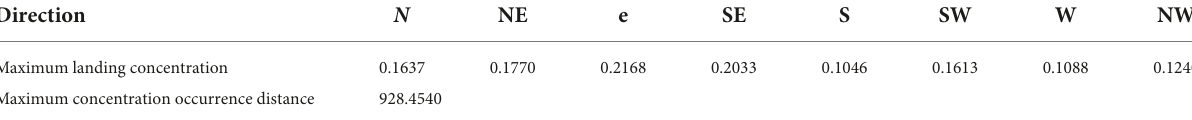
TABLE 11 Distances at which maximum landing concentration and maximum concentration in each direction